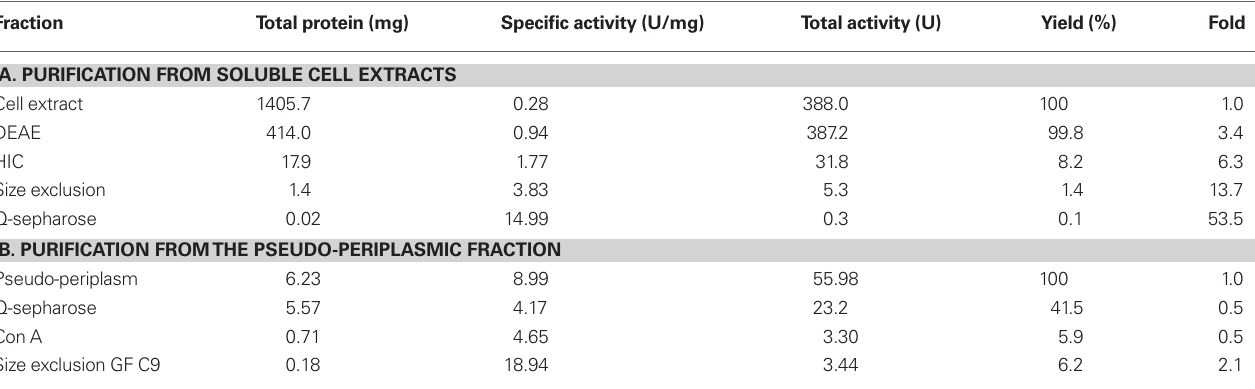
Table 1 | Purification of the tetrathionate hydrolase from A. ambivalens cell extracts.